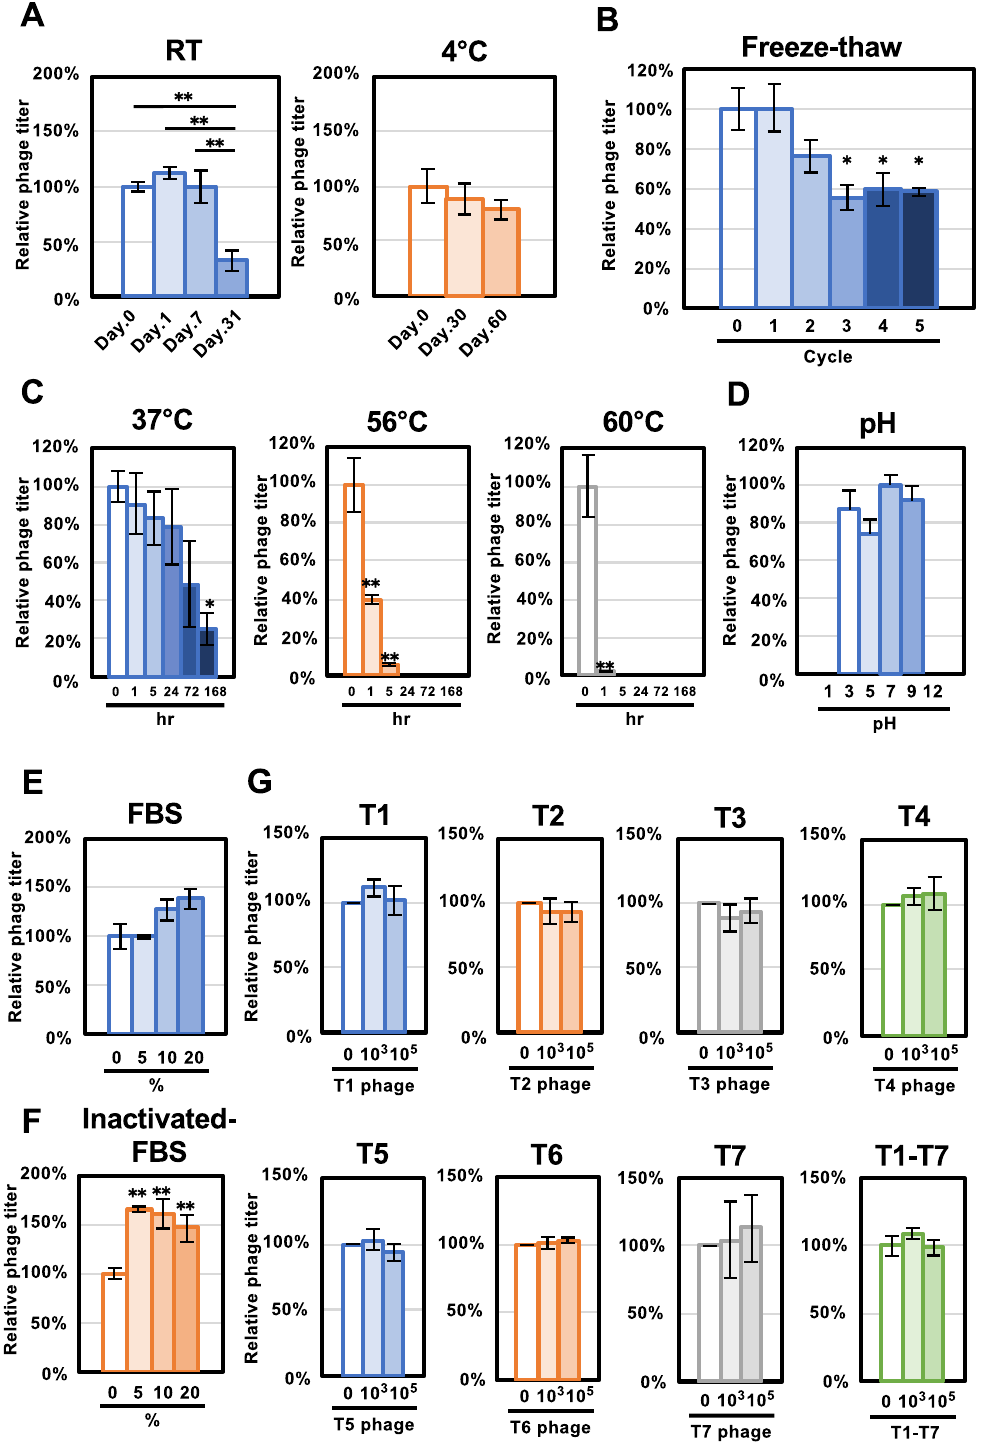
Figure 3. ΦSA012 stability against several environmental conditions. ( A ) Phage stability against storage conditions at room temperature and 4 °C. ΦSA012 infectivity is indicated as fold changes compared to day 0 and is presented as means ± SD (n = 3). ( B ) Environmental resistance of ΦSA012 against freeze–thaw cycles. The titer of ΦSA012 is indicated as the fold change compared to cycle 0 and is presented as means ± SD (n = 3). ( C ) Phage stability at temperatures of 37 °C, 56 °C, and 60 °C. The titer of ΦSA012 is indicated as the fold change compared to 0 h and is presented as means ± SD (n = 3). ( D ) Phage stability against different pH ranges. The titer of ΦSA012 is indicated as the fold change compared to pH 7 and is presented as means ± SD (n = 3). ( E and F ) Effects of serum on the plaque-forming activity of ΦSA012. The titer of ΦSA012 is indicated as the fold change compared to 0% FBS and is presented as means ± SD (n = 3). ( G ) Effects of other phage particles on the plaque-forming activity of ΦSA012. The titer of ΦSA012 is indicated as the fold change compared to non-treated ΦSA012 and is presented as means ± SD (n = 3). The significance compared to the control under each condition was analyzed by Tukey’s test based on one-way ANOVA: * p < 0.05, ** p <